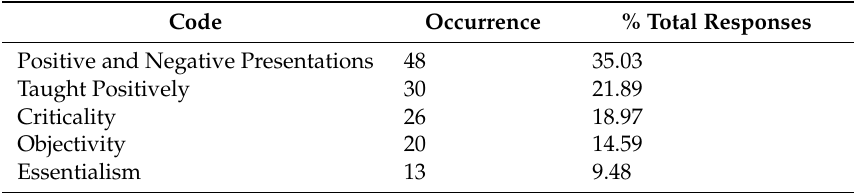
Table 4. Question 24: Religion should be taught in a positive way in RE: